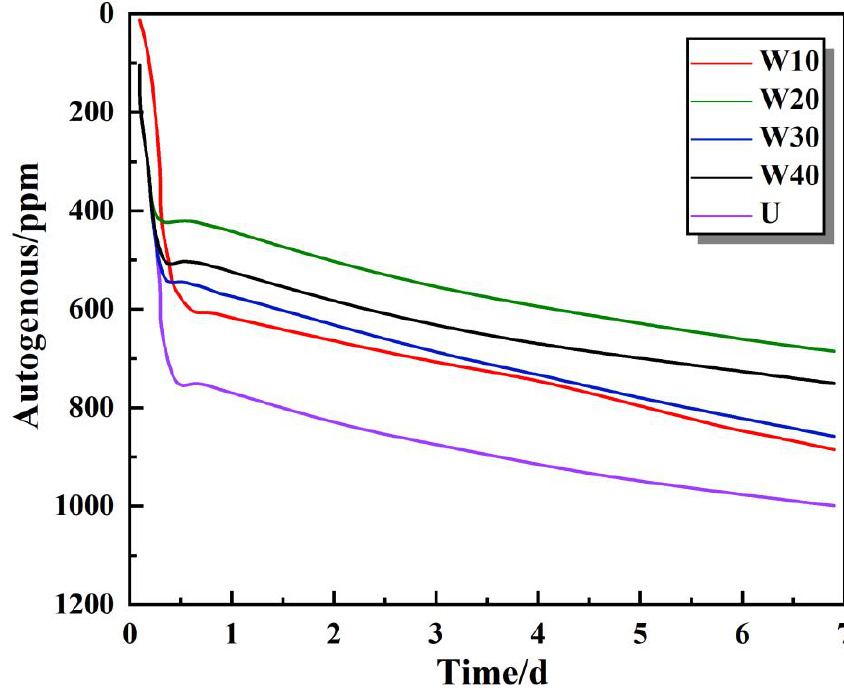
Figure 7. Autogenous shrinkage of UHPC with different contents of lead – zinc tailings [106].